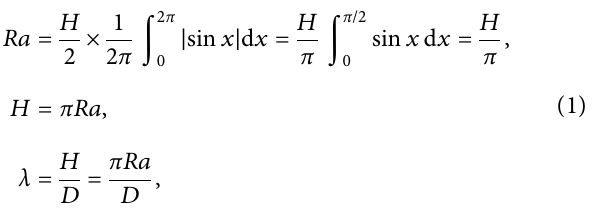
Figure 2: Schematic diagram of the pin-on-disc